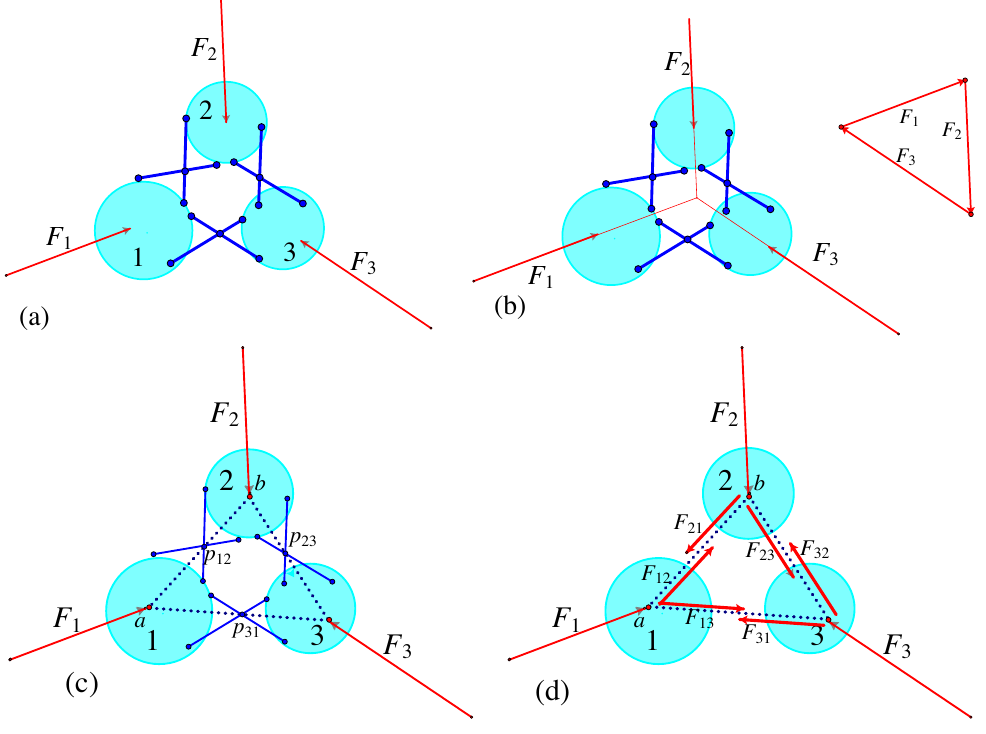
Figure 51. Given a body-bar framework with a load ( a ), we can graphically confirm it is an equilibrium load ( b ). With the two bars joining a pair of bodies, a resolution will use a line through their crossing point ( c ) and give forces along these lines ( d ) to resolve the